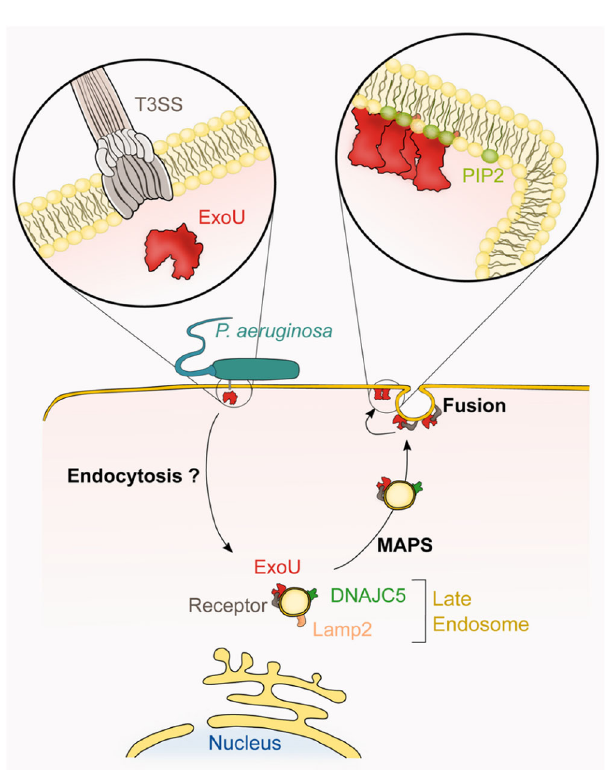
Fig. 7 Proposed model of ExoU traf fi cking in host cells. Upon delivery into the host cytoplasm by the T3SS, the toxin uses an endocytic pathway to reach the perinuclear region, as suggested by ExoU/EEA1 colabeling. Then, ExoU binds to the late endosome ’ s limiting membrane (decorated by Lamp2 and DNAJC5), thanks to the interaction of ExoU with an as yet unidenti fi ed speci fi c receptor at the vesicle ’ s surface. ExoU remains at the external side of the vesicle ’ s membrane and co-opts the DNAJC5- dependent MAPS pathway to achieve anterograde transport toward the cellular periphery (where vesicles loose Lamp2), and eventually the plasma membrane (PM). Fusion of vesicles with the PM brings ExoU close to PM ’ s inner lea fl et, where its membrane localization domain binds to PI(4,5)P2. PI (4,5)P2 binding triggers conformational changes in ExoU, leading to toxin oligomerization and activation of its phospholipase activity, which eventually induces PM